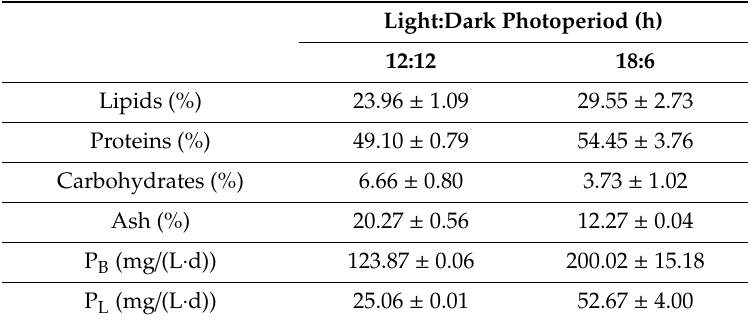
Table 1. E ff ect of the photoperiod on biomass composition and productivities. P B : biomass and P L : lipid productivities.